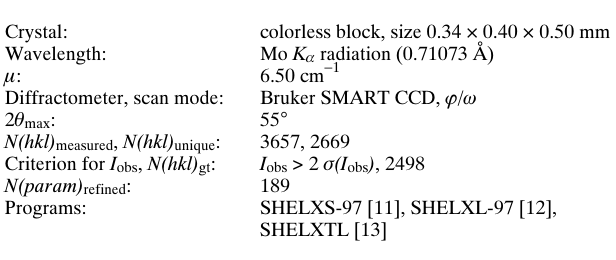
Table 1. Data collection and